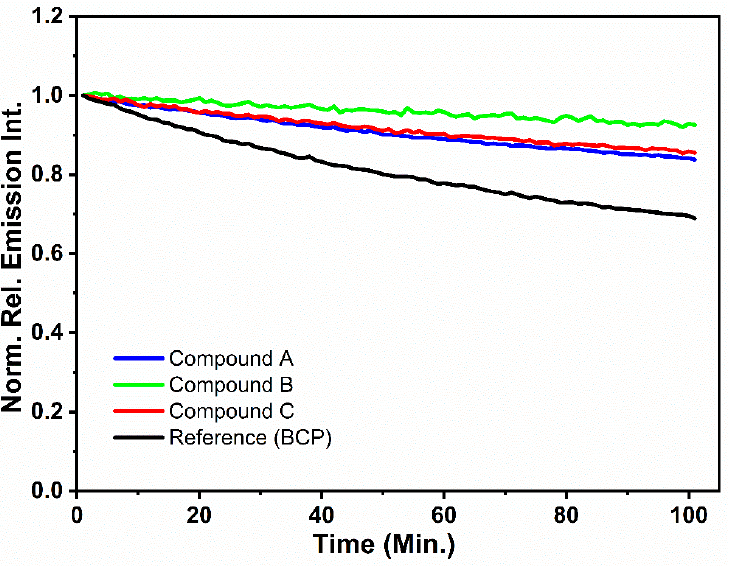
Figure 3. Time-dependent relative photoluminescence intensity change curves for compounds A , B , and C as thin films irradiated over a time period of 100 min.